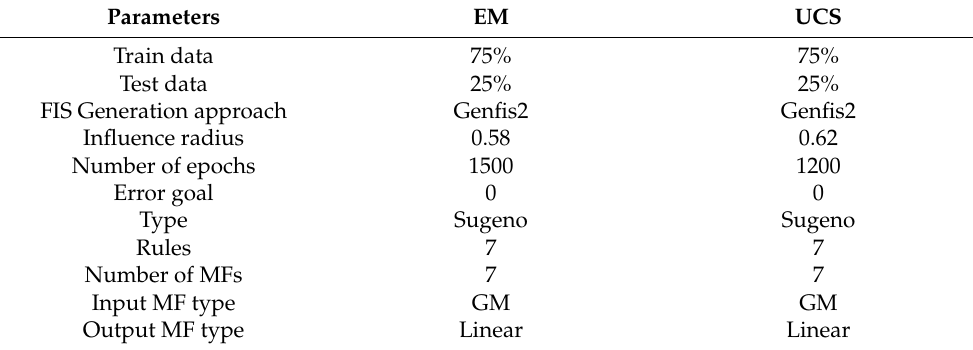
Table 7. Used ANFIS model components.